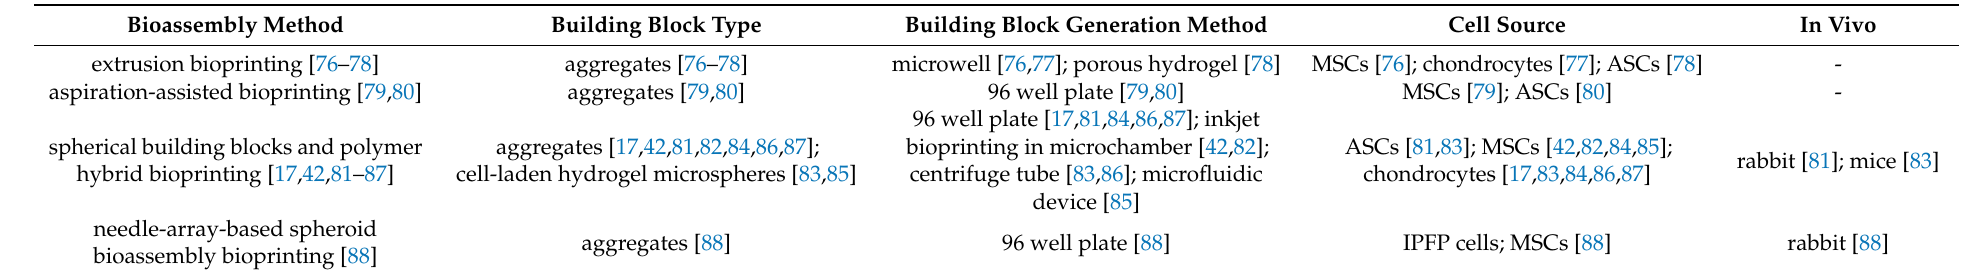
Table 2. Summary of the bioprinting bioassembly